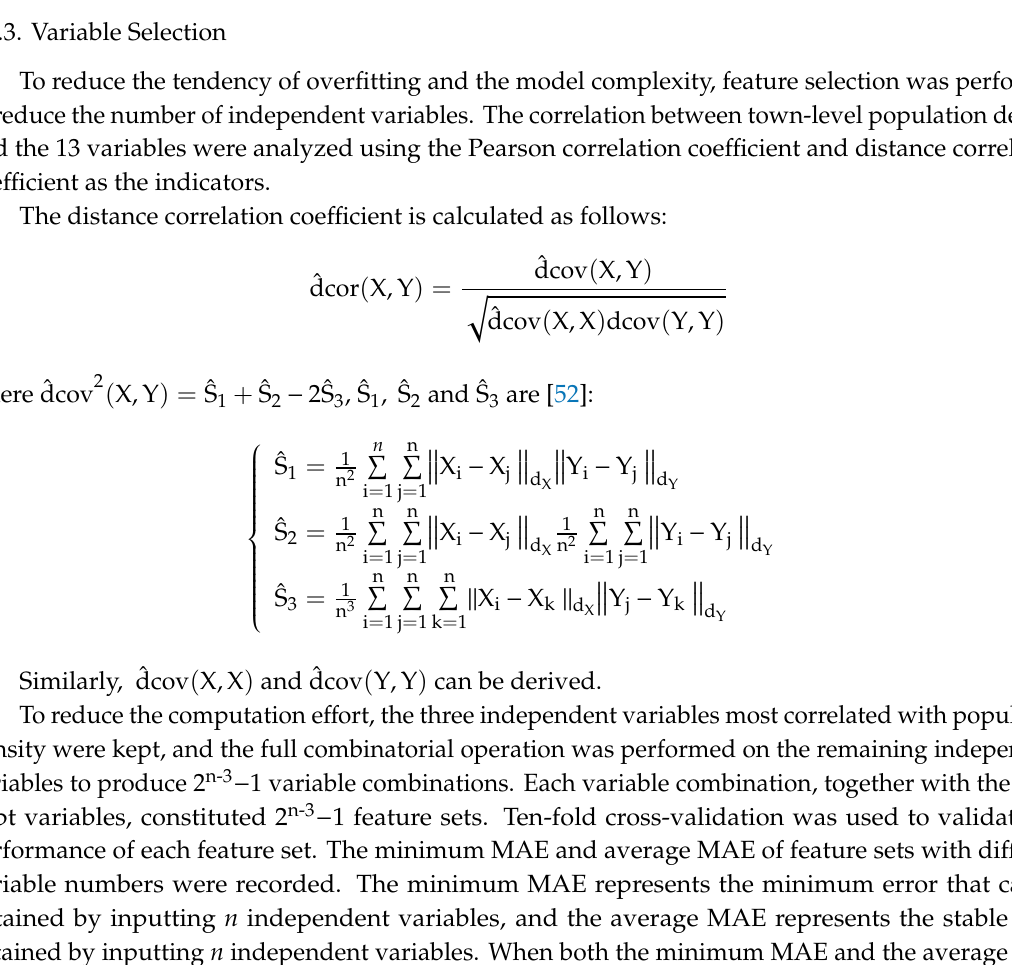
Table 1. Tuned parameters for the six models in this study. Model Tuned Parameter MLR / LASSO fraction